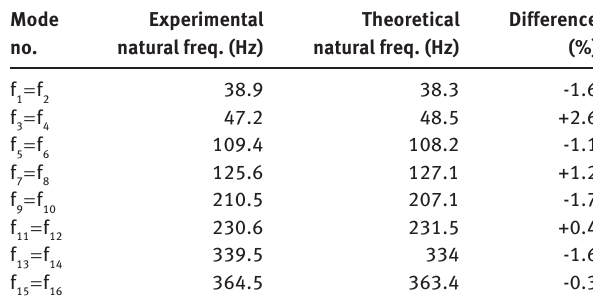
Table 10: Comparison between experimental natural frequencies of truncated cone # 1 (before and after autoclave).